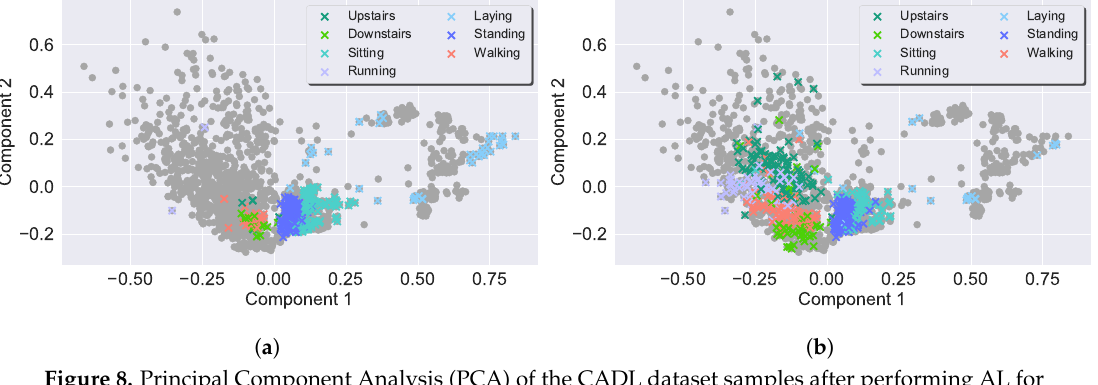
Figure 8. Principal Component Analysis (PCA) of the CADL dataset samples after performing AL for 50 iterations. The classifier’s training set samples are depicted by the × ’s, whose colour identifies their respective class. The darker grey dots represent the unselected samples existent in the validation set.